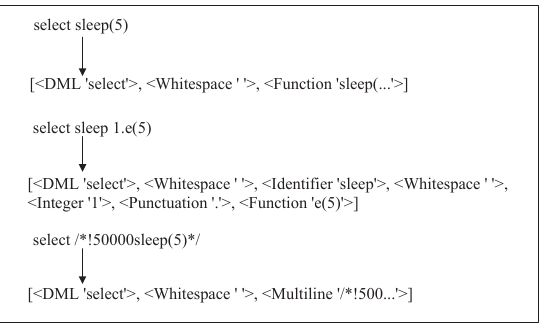
Figure 5. Execution results of the libinjection library for two coding